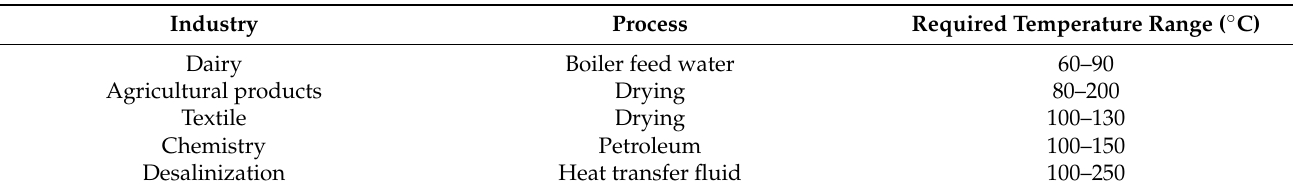
Figure 19. Example of a parabolic trough solar collector system, where ( a ) shows the physical device, ( b ) illustrates its schematic diagram, and ( c ) demonstrates the reflection mechanism of solar radiation on the absorber tube [298]. Table 6. Examples of different industrial processes that utilize parabolic trough solar collector systems and their temperature requirements.